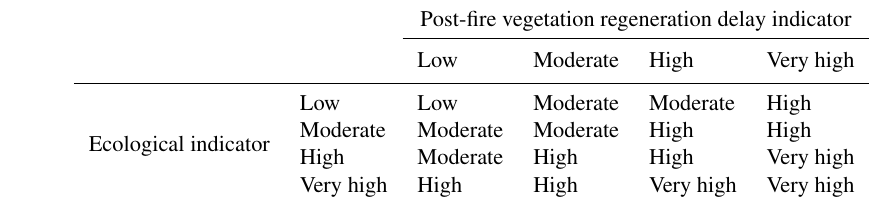
Table 10. Criteria for assigning ecoregions to the different ecological vulnerability index categories in order to test the OAT.